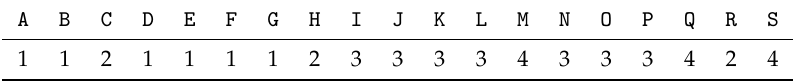
Table 1. Community assigned to each vertex in the solution depicted in Figure